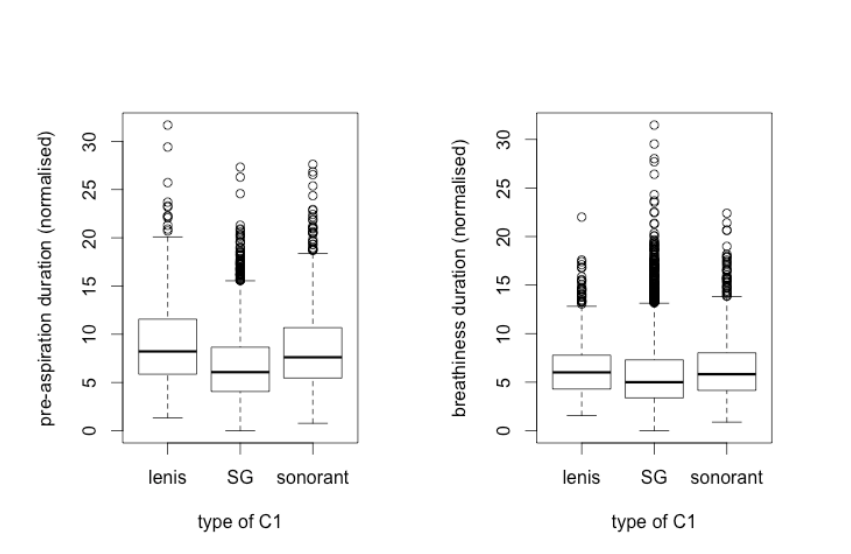
Figure 4: Normalised duration, for pre-aspiration (left) and breathiness (right), depend- ing on the type of C 1